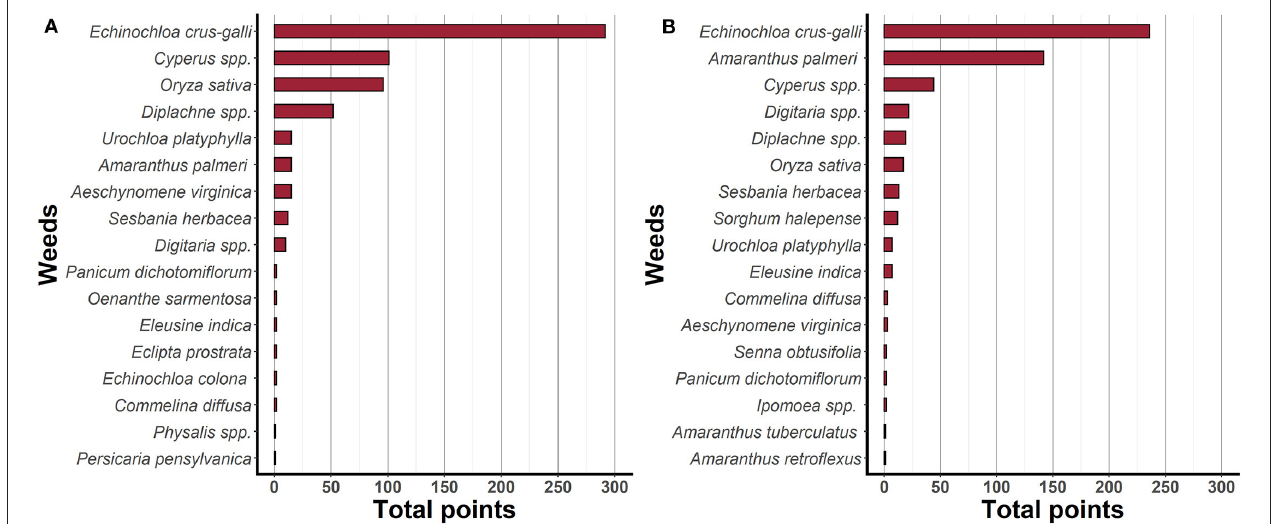
FIGURE 1 | Most problematic weed species reported in (A) paddy rice ( N = 105) and (B) furrow-irrigated-rice ( N = 92). Weeds listed as the #1, #2, and #3 most problematic were awarded 3, 2, and 1 points, respectively. Greater total points indicate the respective weed species was more consistently listed as a top